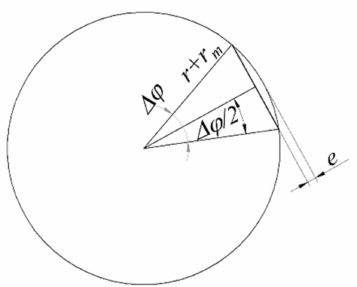
Figure 13. Polygonal approximation of the